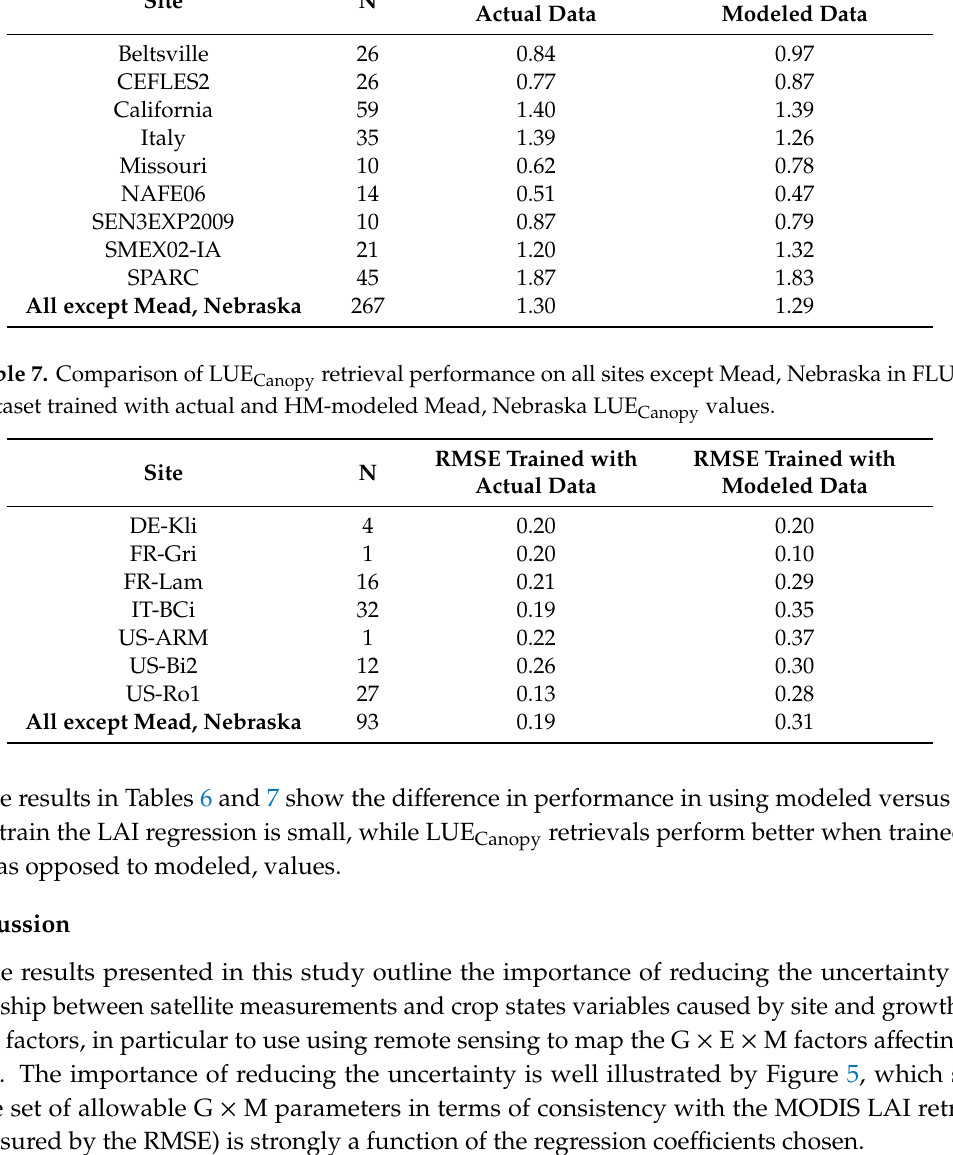
Table 6. Comparison of LAI retrieval performance on all sites except Mead, Nebraska in LAIGROUND dataset trained with actual and HM-modeled Mead, Nebraska LAI values. Only sites with ≥ 10 points listed site-by-site; all points included in last row. RMSE Trained with RMSE Trained with Site N Actual Data